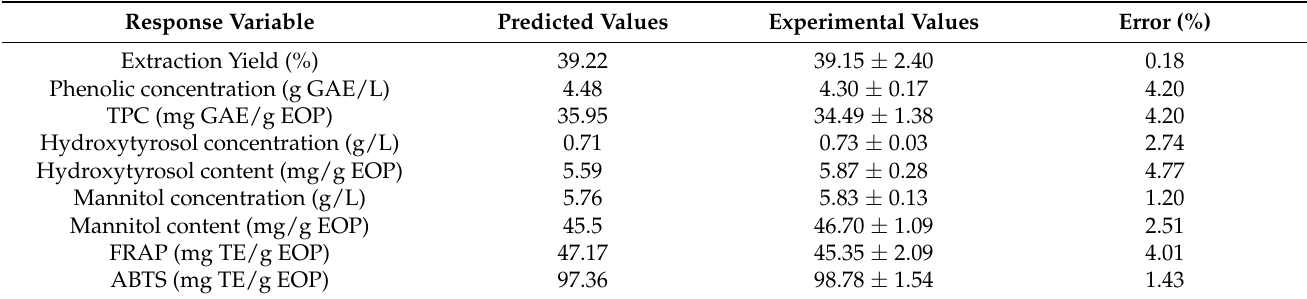
Table 3. Predicted results obtained by the model at optimal conditions (12% w / v , 100 ◦ C, and 16 min) and experimental results measured after the application of these conditions. Data represent the mean value and standard deviation (n =